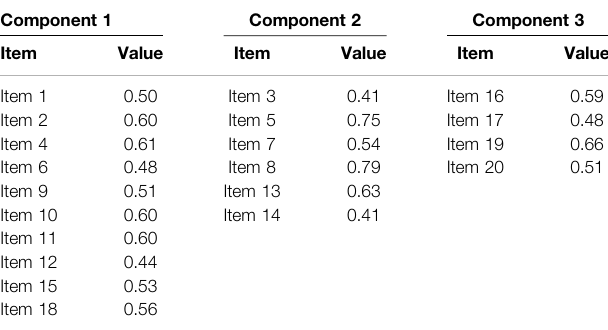
TABLE 3 | Distribution of the items in three components.